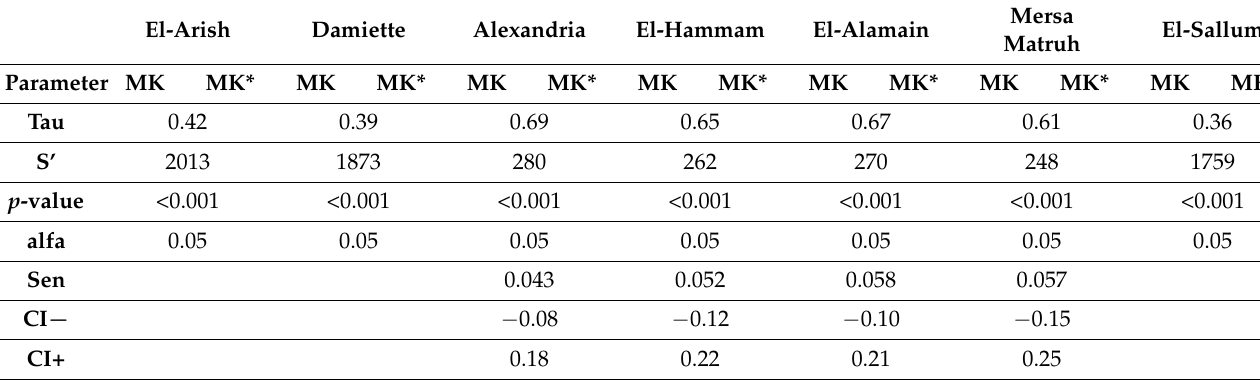
Tau: measure of concordance between two observed variables; TM: maximum temperature ( ◦ C); Tm: minimum temperature ( ◦ C); S’: Mann–Kendall statistic; p -value: level of uncertainty in the test; alfa: confidence level; Sen: value of the coefficient of Sen; CI − : lower threshold of the confidence interval; CI+: upper threshold of the confidence